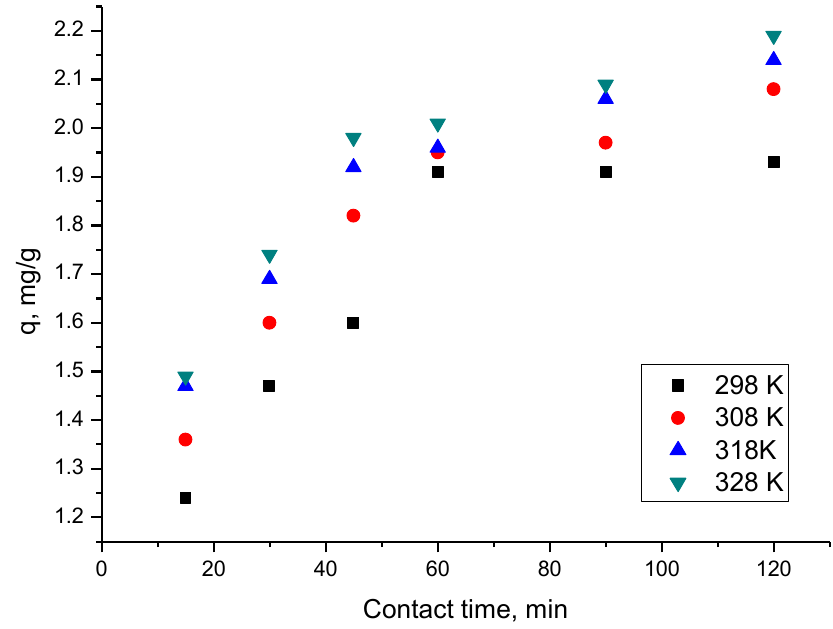
Figure 3. The influence of pH on the adsorption capacity of GDAH-04-300 material.